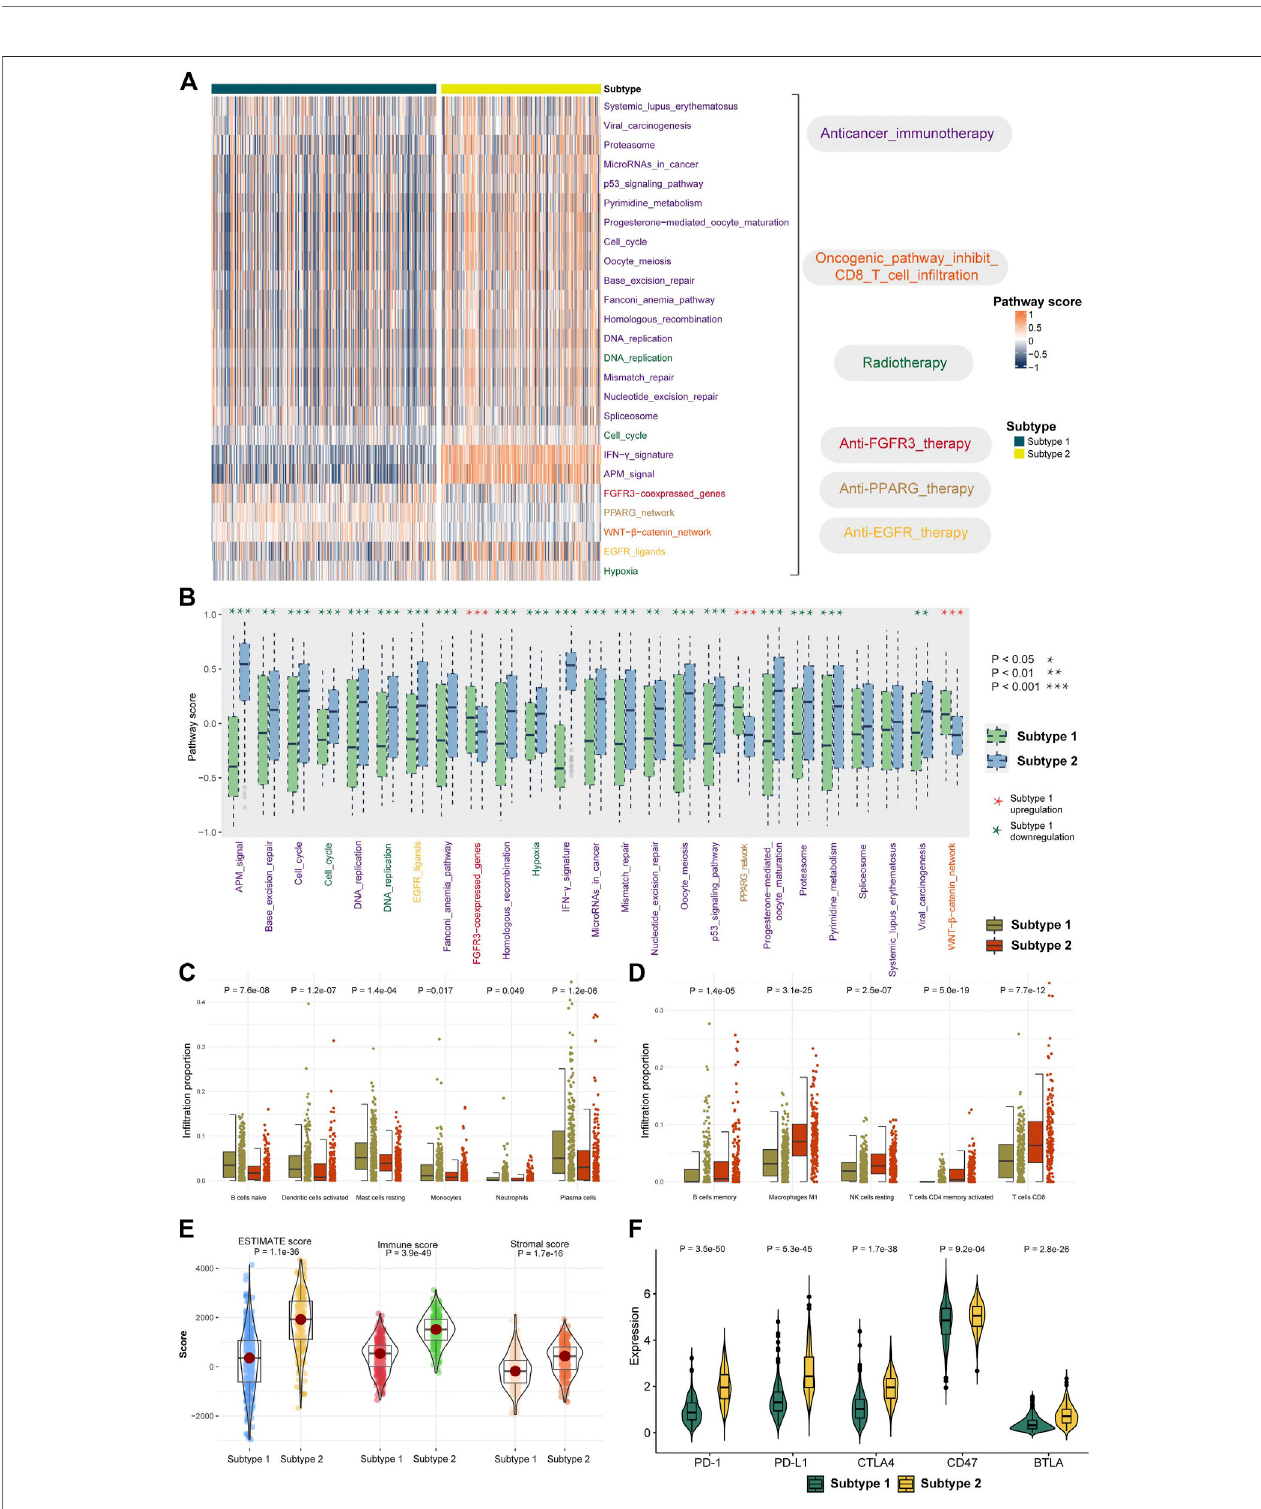
FIGURE 3 | Distinction of therapeutic signature and TME between the subtypes. (A) Heatmap showed the GSVA score of 25 therapeutic signature gene sets in TCGA LUAD samples. The therapeutic signature gene sets belong to six categories. (B) Distribution of therapeutic signature score between two subtypes. (C – D) Abundance of in fi ltrating immune cell types in two subtypes. (E) Distribution of the ESTIMATE score in two subtypes. (F) Expression levels of fi ve checkpoints in two subtypes.